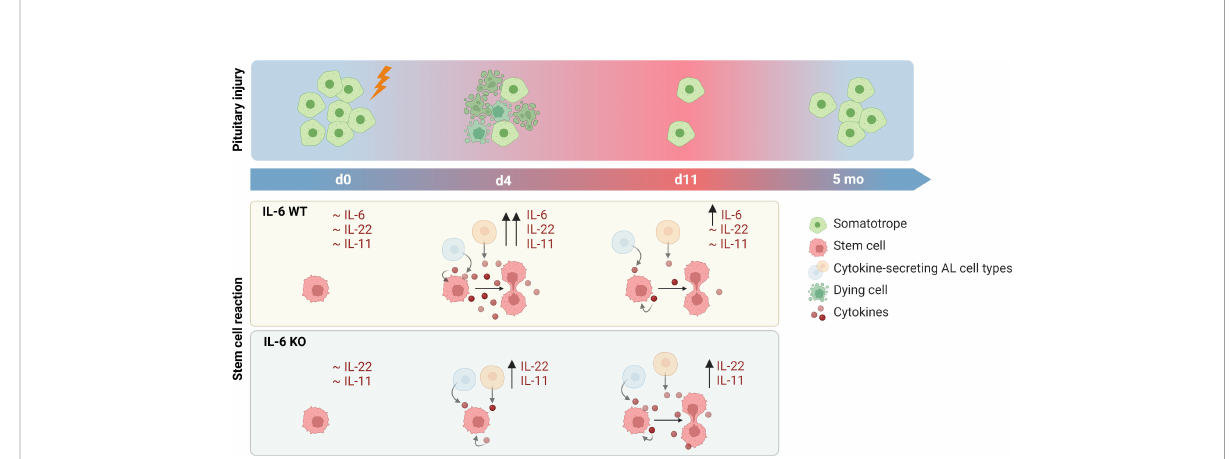
FIGURE 5 Proposed hypothesis on role of IL-6 in pituitary stem cell activation and regeneration upon local injury. In unperturbed (IL-6 WT) conditions, levels of cytokines are at basal (low) level. Upon local damage, expression is promptly upregulated (d4) and stem cells are activated into proliferation. One week later (d11), levels of cytokines except IL-6 have returned to basal levels. In the absence of IL-6 (IL-6 KO), cytokines (in particular IL-22 and IL-11) are also acutely upregulated (d4) following local injury although at lower level than in IL-6 WT conditions, while stem cells do not show activation at this timepoint. However, expression levels remain high for a longer period (d11), possibly resulting in stem-cell proliferative activation which thus might occur in a delayed manner in the absence of IL-6. In both IL-6 WT and KO conditions, signi fi cant regeneration of the ablated endocrine cells is eventually realized (created with